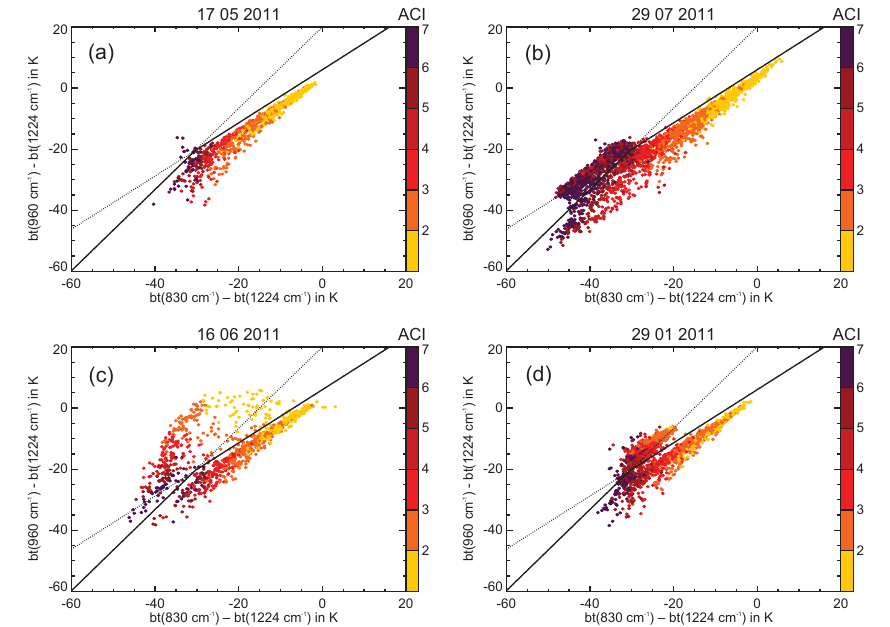
Figure 5. MIPAS brightness temperature difference correlations for selected scenarios: (a) ice clouds (0–60 ◦ S), (b) Nabro sulfate aerosol (0–90 ◦ N) and ice clouds, (c) Puyehue–Cordón Caulle volcanic ash (0–60 ◦ S) and ice clouds, and (d) PSCs (0–90 ◦ N) and tropospheric ice clouds. All figures comprise all orbits (about 14) measured on the day given on top of each plot. The black lines are the ice separation thresholds derived from the observations, where the solid part of each line denotes the relevant part for the discrimination between aerosol and